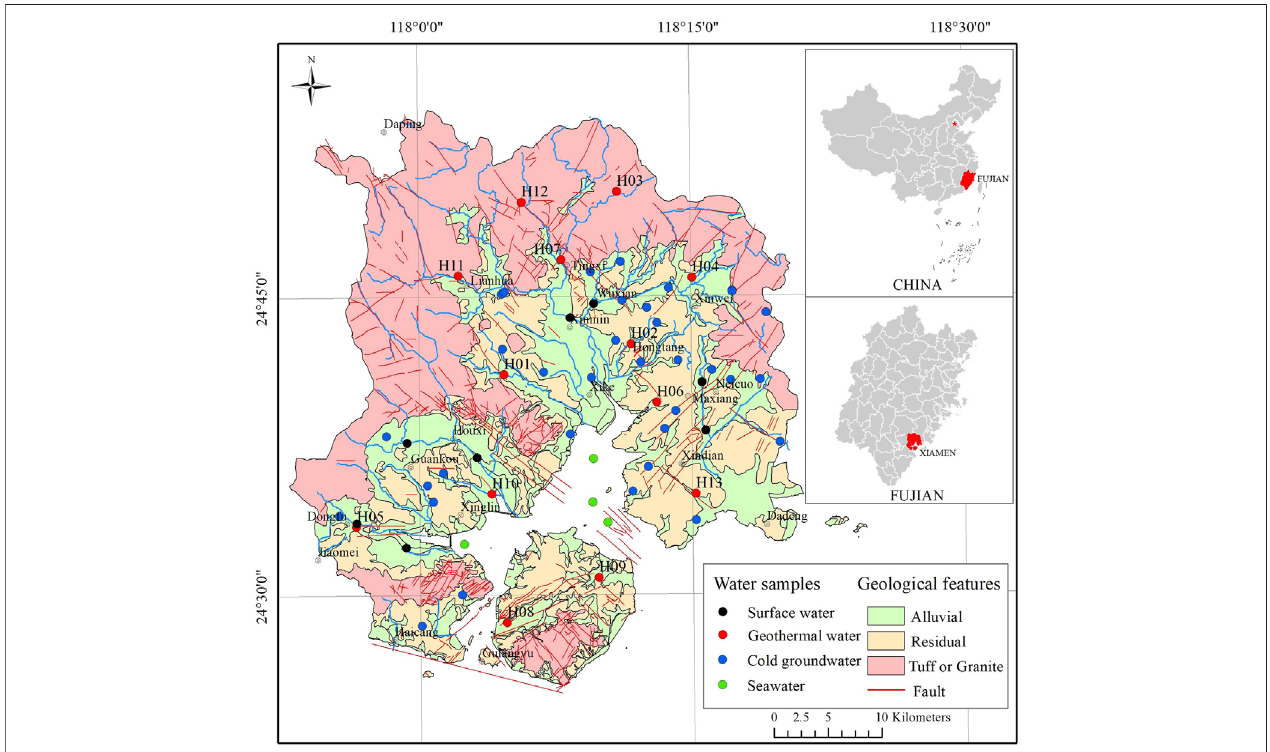
FIGURE 1 | Geological sketch of Xiamen and the distribution of sampling